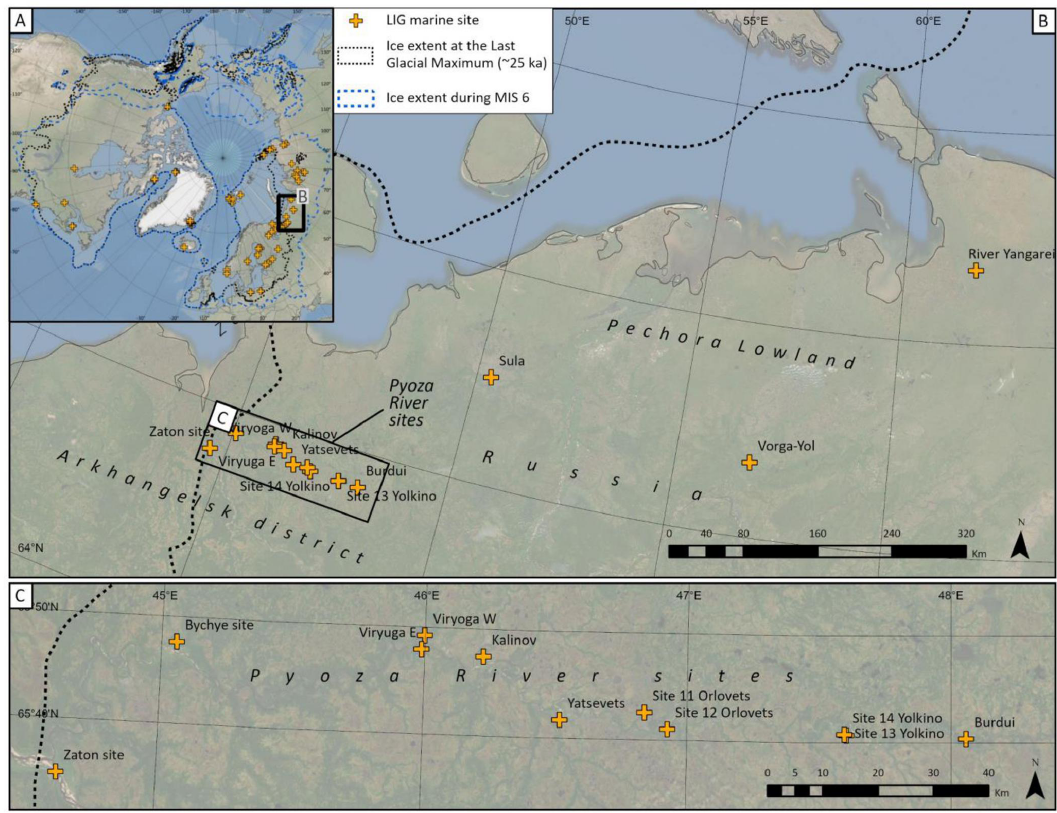
Figure 5. The locations of LIG marine sites in the Arkhangelsk district and Pechora Lowland, Russia. Panel (a) situates the sites in the Northern Hemisphere, whereas panels (b) and (c) provide regional maps. Sites plotted on this map are detailed in Sect. 6.12–6.15. Extent of MIS 6 and Last Glacial Maximum ice sheets after Batchelor et al. (2019). Scale calculated at the centre of the mapped area. Base layer: ArcGIS World